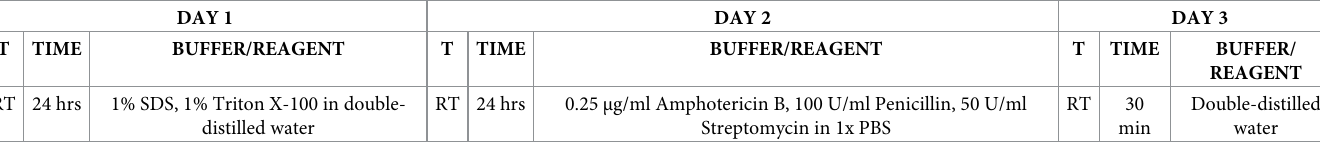
Kit (Qiagen, Hilden, Germany) instructions, showed a removal of dsDNA of 97.90 ± 0.86% confirming the efficacy of the decellularization (Fig 2D). The absence of residual DNA frag- ments was also checked out by the electrophoresis on agarose gel, showing no DNA band for d-ECM (Fig 2C). Minimal data set are available in Supporting information (S1 Data). Additionally, the content and the distribution of the specific ECM proteins appears unal- tered, as showed by the histochemical analysis. Masson’s and Mallory’s trichrome and Sirius Red stainings showed the preservation of col- lagen fibers as well, while PAS Morel-Maronger and Gomori’s stainings make evident the retention of non-collagenous proteins and elastic fibers, respectively (Fig 3). Additional images are available in Supporting information (S1 Fig). The content of collagen and sulfated glycosaminoglycan (sGAG) was investigated by Sircol or Blyscan quantitative dyebinding assay, respectively. The quantitative measurements of col- lagen and sGAG in d-ECM demonstrates a high retention of both components. Accordingly, collagen residual content resulted 56.55 ± 8.07%, while sGAG showed a retention of 59.30 ± 3.85% (Fig 4). Minimal data sets are available in supporting information (S2 and S3 Data). Immunohistochemistry also highlights the retention of fibronectin, laminin, and tenascin in the decellularized extracellular cardiac matrix, supporting that the decellularizing method is conservative for the structural proteins as well (Fig 5). Additional images are available in Supporting information (S2 Fig). Real-Time PCR revealed that d-ECM obtained with the described protocol supports cell liv- ing through and differentiation towards cardiac lineages. Bioconstructs were prepared by